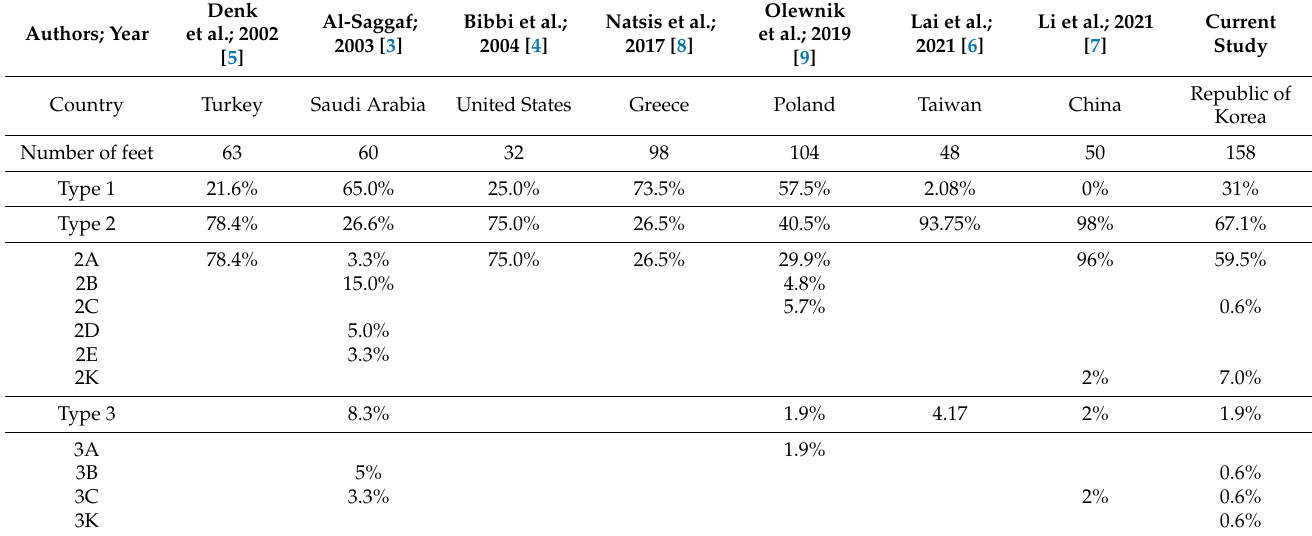
Table 4. Comparison between the current study and previous studies of the extensor hallucis longus (EHL) tendon variations using the classification system by Zielinska et al.